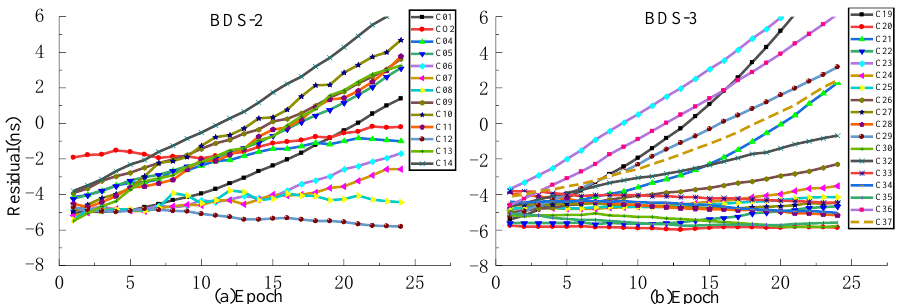
Figure 12. The residual plot of the SSA-ELM model using the initial hour update ultra-fast clock product of the next day. ( a ) The residual value of BDS-2 predicted after 6 h. ( b ) The residual value of BDS-3 predicted after 6 h.